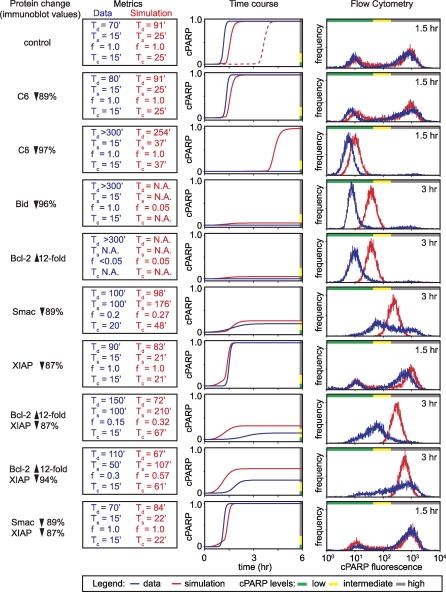
Training the Model on Network-Wide PerturbationsFirst column: perturbation values measured by immunoblot (see Figure S2). Second column: comparison of EARM v1.0-simulated and experimentally derived values for Ts, Td, f, and Tc. Simulated values were computed by EARM v1.0 with the perturbation conditions indicated in the first column. Experimental values were derived by fitting the simFACS data model to discretized flow cytometry data (See Materials and Methods and Protocol S2 for details). Third column: comparison of EARM v1.0-simulated cPARP cleavage (red) to time courses derived from flow cytometry using a data model (blue). Blue curves were produced by Equation (1) parameterized with the experimental Ts, Td, and f values shown in the second column. The dashed line in the control condition shows simulation under non-siRNA conditions; all other simulations were performed under siRNA conditions (see “Linking Models and Experiment Via Perturbation” for details). Fourth column: comparison of experimental (blue) and predicted (red) flow cytometry plots at the indicated time points (see Figure S3 for comparisons of all time points). Predicted flow cytometry data were produced by simFACS data simulation using the EARM v1.0-simulated values for Ts, Td, and f shown in the second column. Raw data for several of the conditions shown were originally reported elsewhere [15].